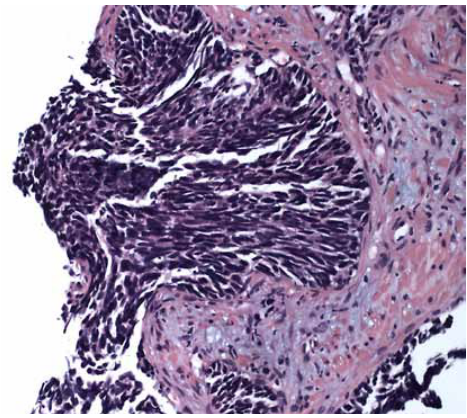
Figure 6 - Small cell cacinoma, cytologic findings. Small cell carcinoma. Nucleoli are inconspicuous and cytoplasm are scant. Hematoxilin-eosin,